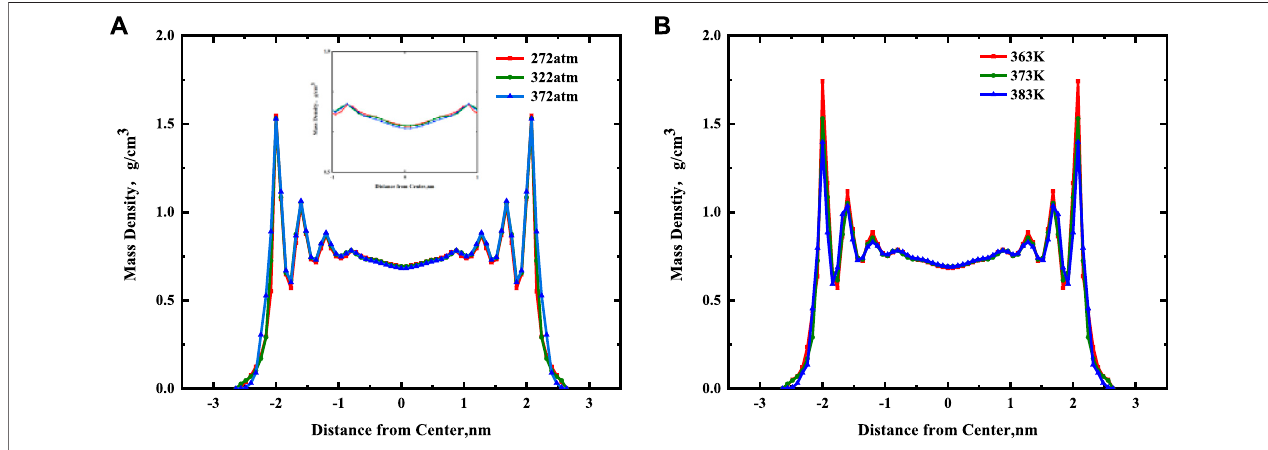
FIGURE 8 | (A) Effect of pressure on the continuous mass density pro fi les for nC19 in the mixed nanopores; (B) Effect of temperature on the continuous mass density pro fi les for nC19 in the mixed nanopores.